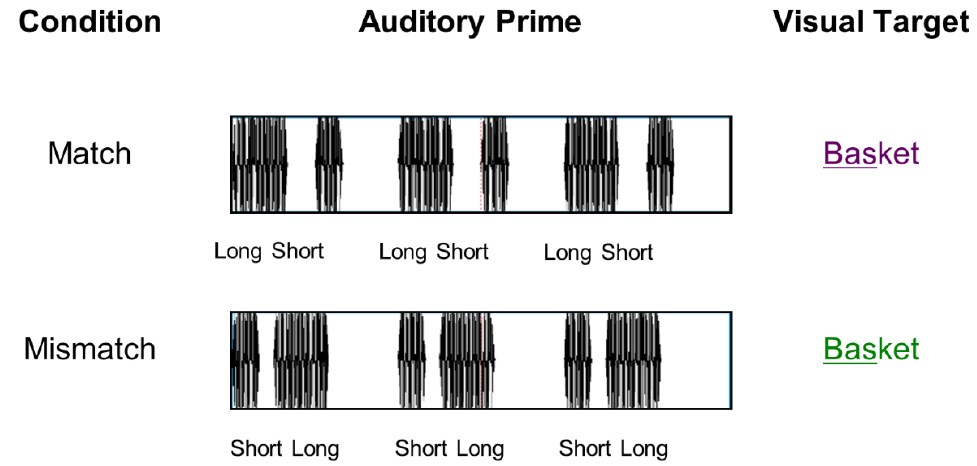
Figure 1. Rhythmic cross-modal priming experimental paradigm. The auditory prime (long-short or short-long sequence) is followed by a target visual word with a stress pattern that either match or mismatch the prime (Note: stressed syllable is underlined for illustration purposes only).